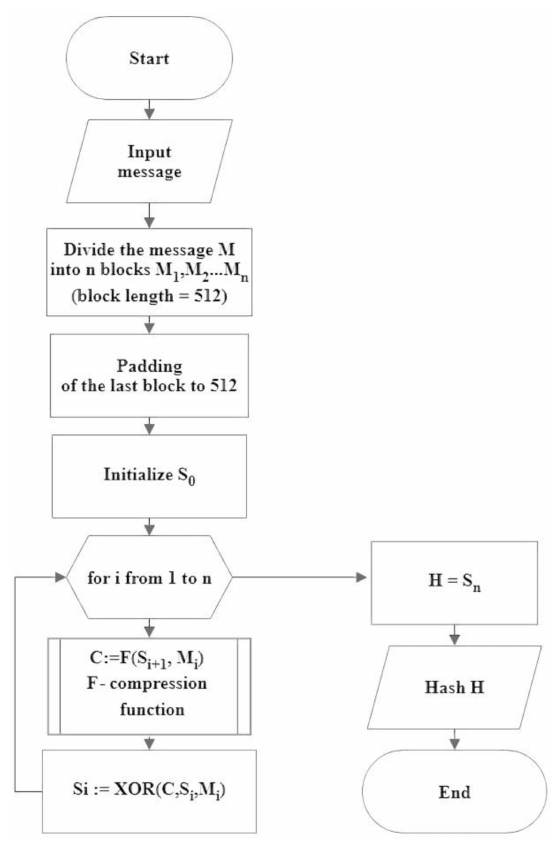
Figure 2. The flow chart of the implemented hash